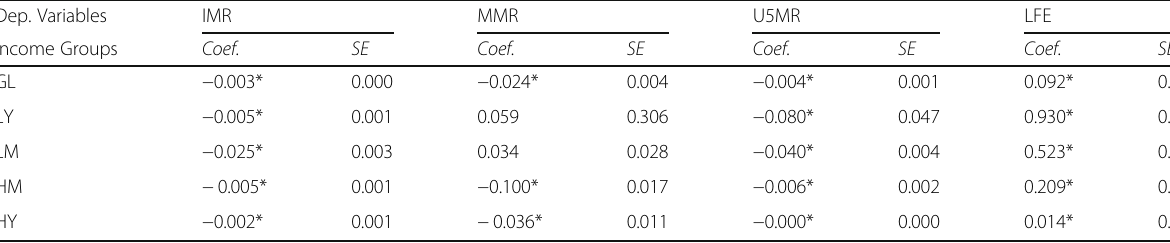
Table 4 Fully modified ordinary least square (FMOLS) test Dep. Variables Income